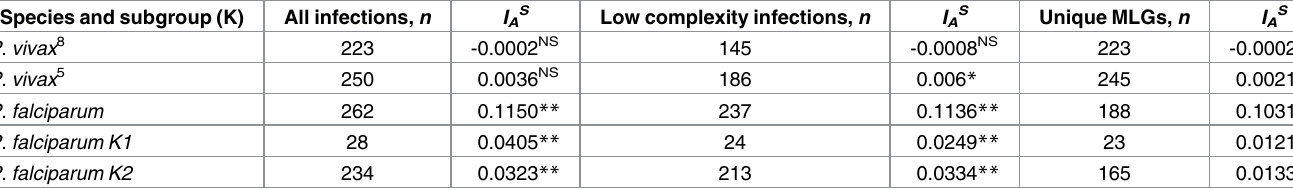
Table 3. Linkage disequilibrium.